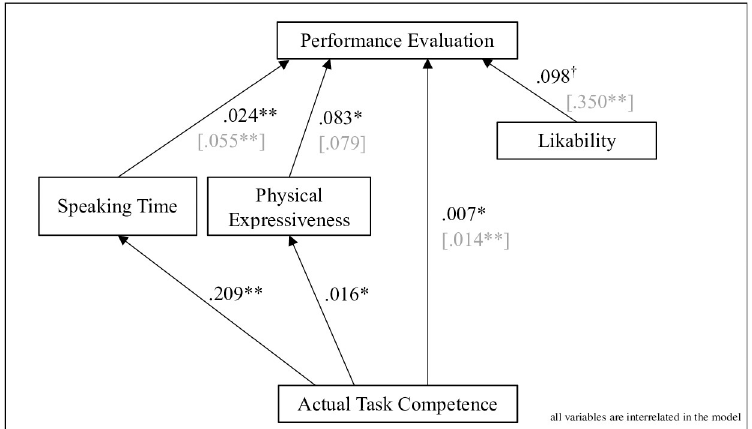
Fig 3. Mediation analysis of performance evaluations made by group members and [qualified observers]; unstandardized path coefficients.